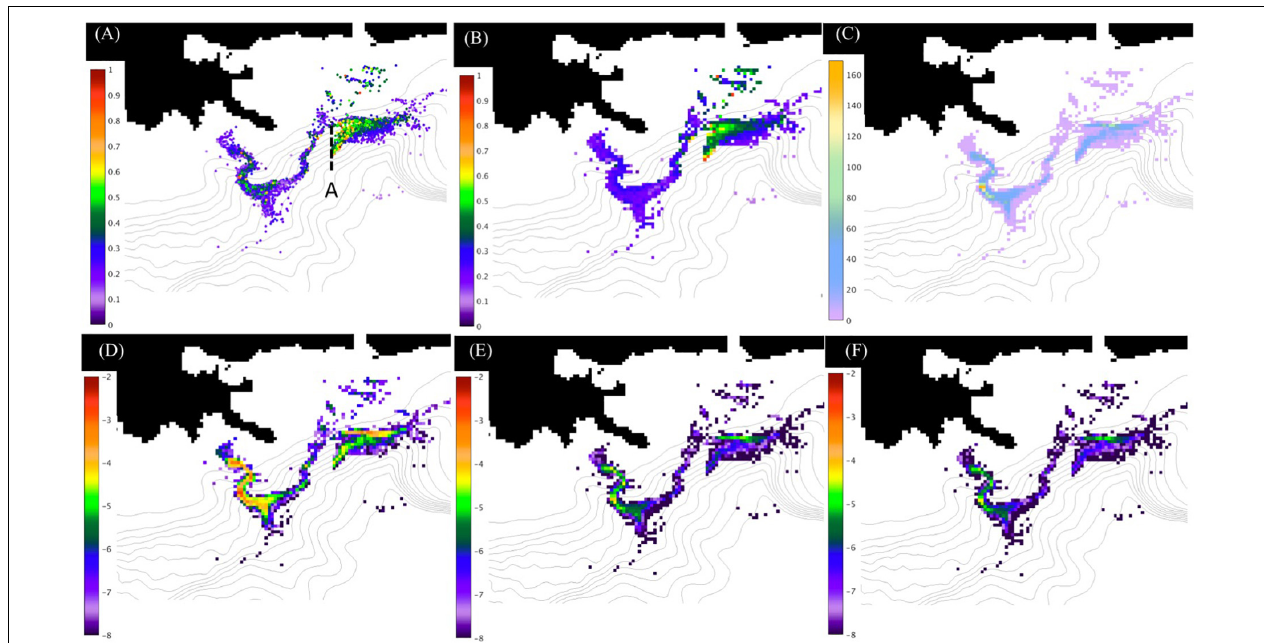
FIGURE 6 | Demonstration of the LEM in a ROMS-OTWM test simulation in the model surface layer. (A) The dots indicate locations of individual Lagrangian floats. Colors show mean oil droplet size D oil ( µ m). The dashed line A is the transect shown in Figure 7 . (B–F) oil characteristics mapped onto an Eulerian model grid frame. (B) Mean oil droplet size in the grid cells D ∗ oil ( µ m). (C) Number of floats per grid cell. (D) Concentration of oil compound #1 (saturates), ˜ C ∗ oil ( 1 ) (natural log scale, kg m − 3 ). (E) Concentration of oil compound #2 (aromatics), ˜ C ∗ oil ( 2 ) . (F) Concentration of oil compound #3 (resins and asphaltenes), ˜ C ∗ oil ( 3 )